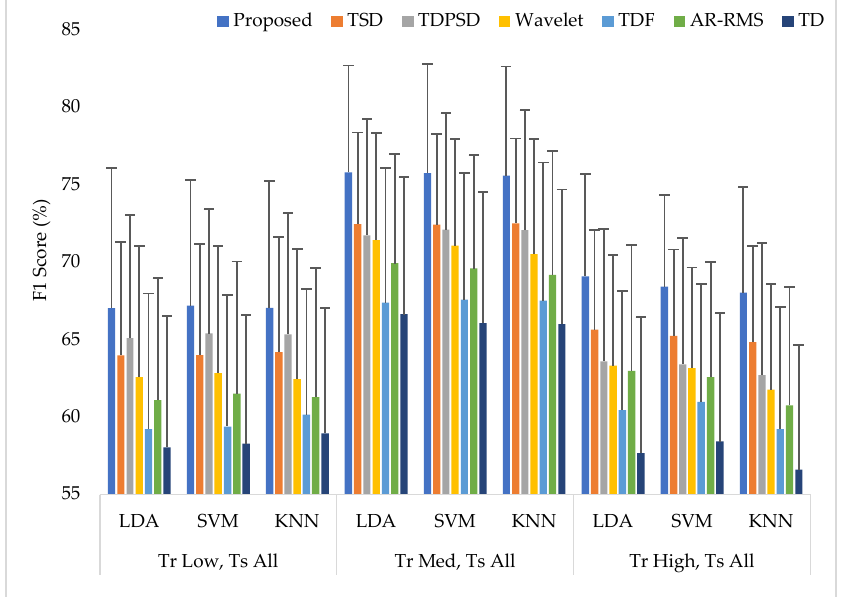
Figure 7. The EMG pattern recognition performances when training the classifiers with a single force level and testing with three force levels, where Tr and Ts indicate training and testing, respectively.